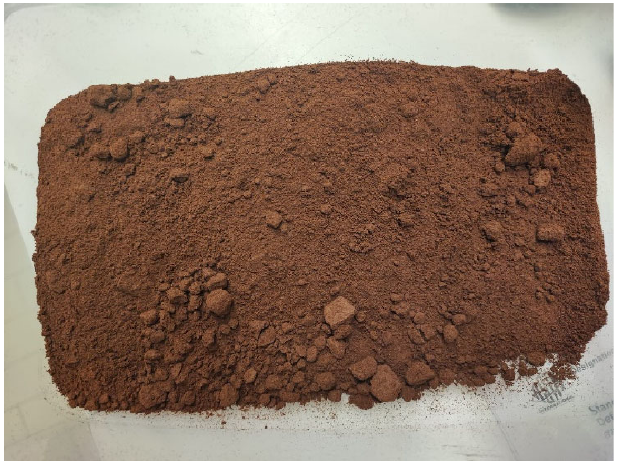
Figure 1. Appearance particle size of hazelnut perisperm powder (<0.25 mm).